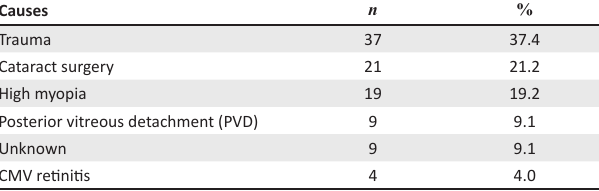
FIGURE 1: A flow chart of records excluded from the TABLE 1: Causes of rhegmatogenous retinal detachment.